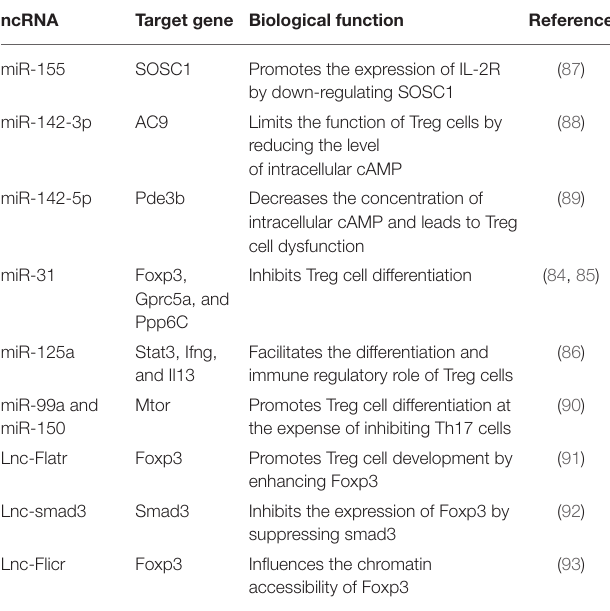
TABLE 6 | ncRNAs involved in Treg